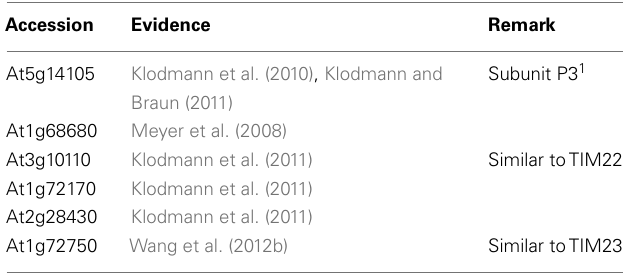
Figure S1 | Principle of 3D BN/SDS/SDS-PAGE. Figure S2 | Replicates of 3D BN/SDS/SDS gels for complex I from cell cultures of Arabidopsis . Figure S3 | Regions on 3D BN/SDS/SDS gels showing the smallest complex I subunits. Gels were Coomassie stained (left, middle) or silver stained (right).The three smallest proteins (corresponding to spots 50, 51, and 52 on Figure 2 ) only become clearly visible upon silver staining. Spot 50 represents the B9 subunit. Spot 51 might represent subunit ND4L. Spot 52 could not be identified. Figure S4 | Species specific complex I subunits in B. taurus and A. thaliana